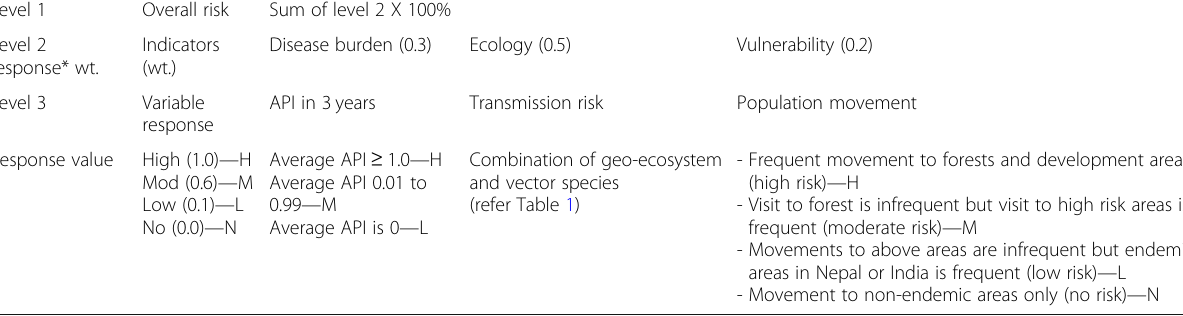
Table 2 Scoring methodology for micro-stratification of malaria risk in Nepal Level 1 Overall risk Sum of level 2 X 100% Level 2 response* wt.